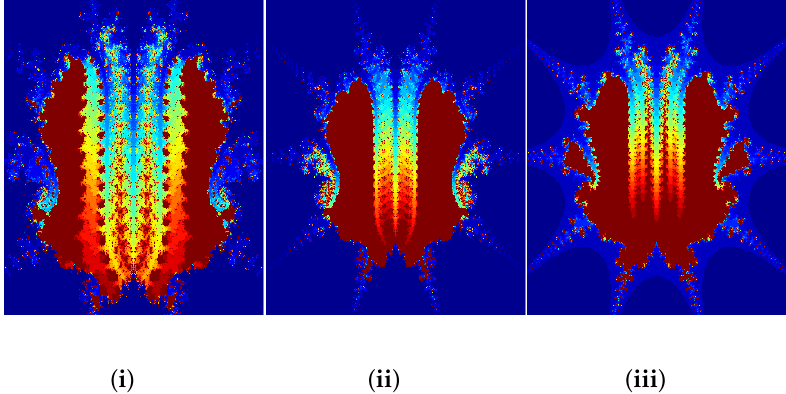
Figure 6. Quintic Julia sets in ( i ) Noor-orbit; ( ii ) Ishikawa-orbit; ( iii ) Mann-orbit.